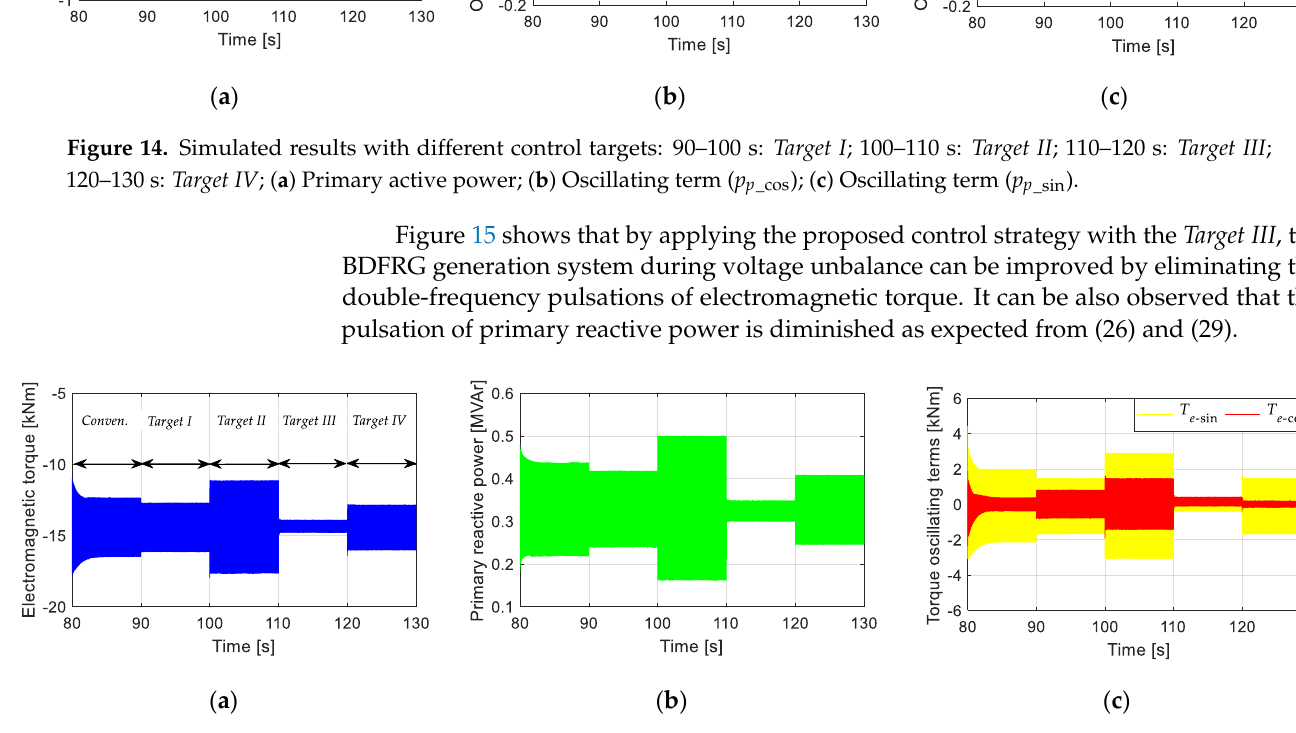
Figure 15. Simulated results with different control targets: 90–100 s: Target I ; 100–110 s: Target II ; 110–120 s: Target III ; 120–130 s: Target IV ; ( a ) Electromagnetic torque; ( b ) Primary reactive power; ( c ) Torque oscillating terms.